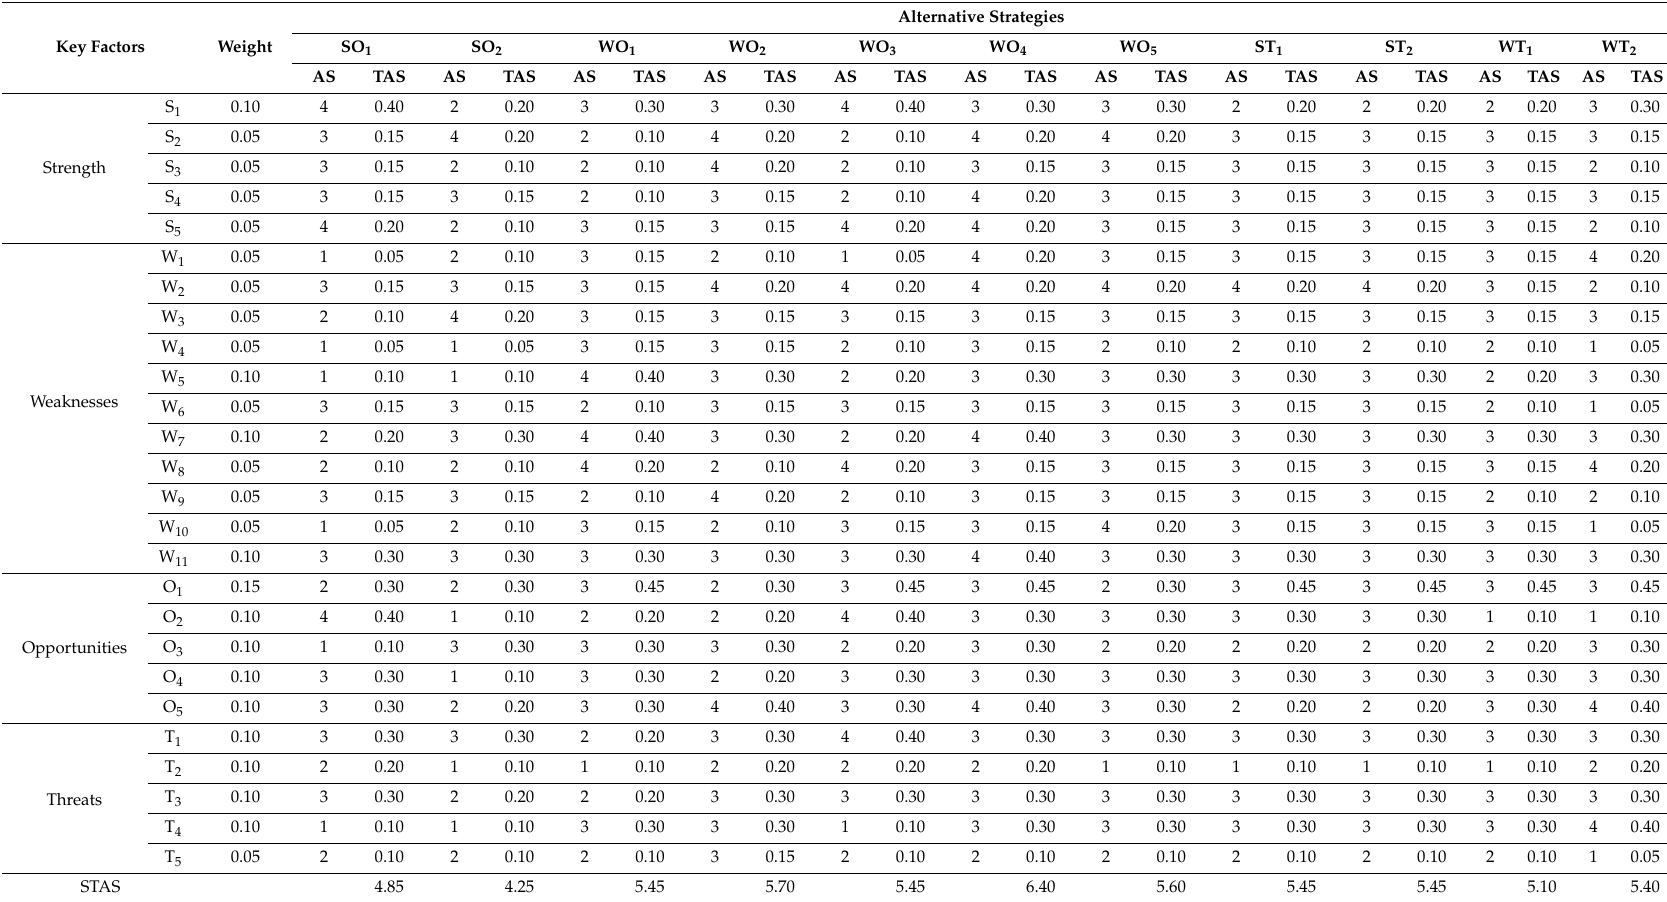
Table 5. Quantitative strategic planning matrix (QSPM)